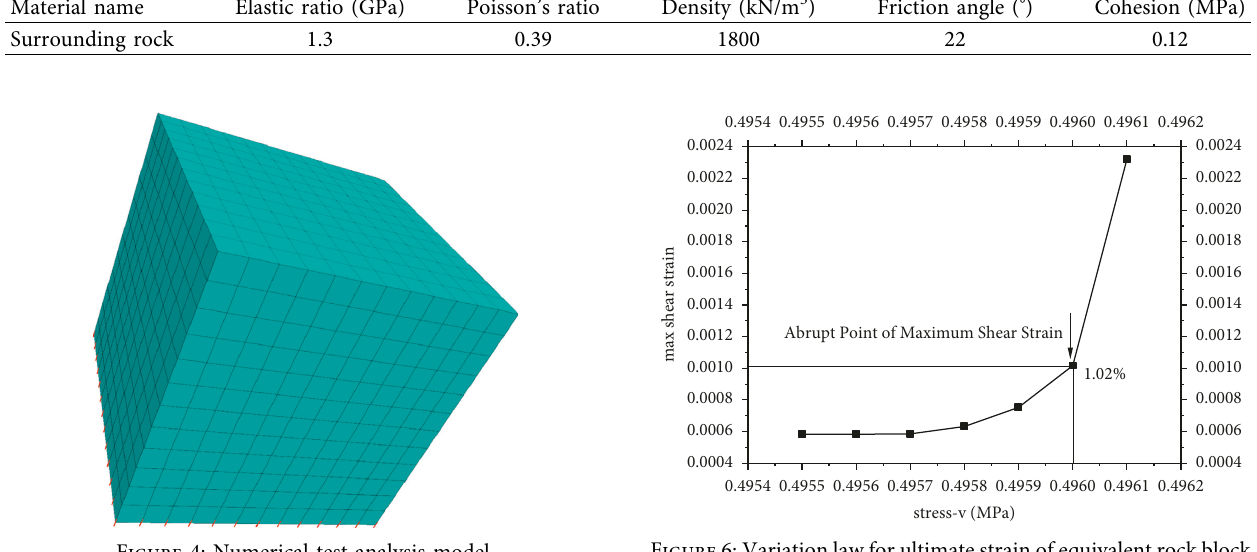
Figure 4: Numerical test analysis model.